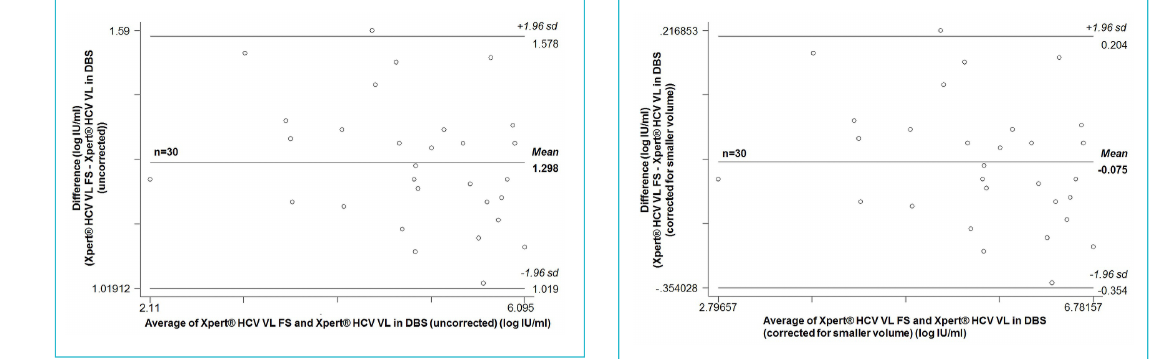
Figure S2: Bland-Altman plot of 30 paired quantifiable HCV RNA measurements: Xpert® HCV Viral Load Fingerstick (VL FS) test versus Xpert® HCV Viral Load (VL) test in dried blood spots pro- duced with 100 µl capillary whole blood (results corrected for the smaller plasma volume). sd = standard deviation; average bias: –0.075 (95% CI –0.127 to –0.023); 95% limits of agree- ment –0.354 to 0.204; Pitman’s test of difference in variance r = -0.283, p =